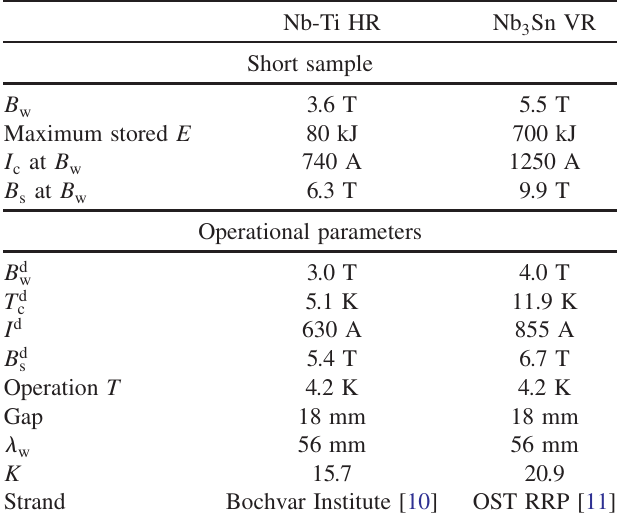
TABLE I. Parameters of wiggler magnet prototypes. HR: hori- zontal racetrack; VR: vertical